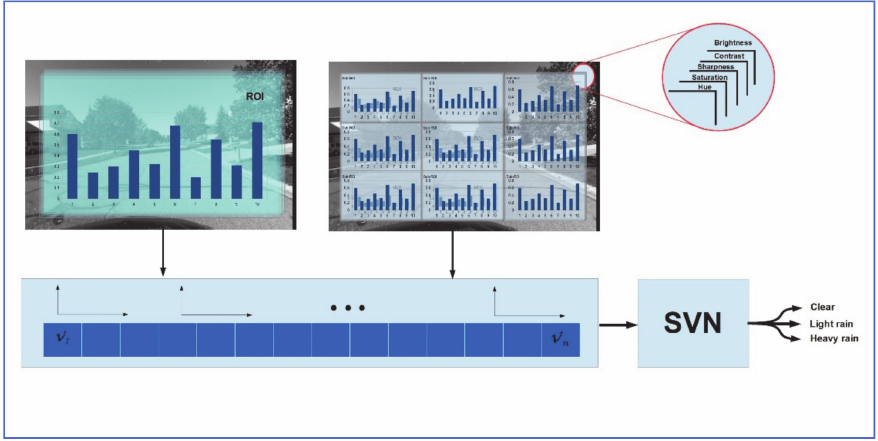
Figure 4. Weather classification using BoF and SVM as described by Roser and Moosmann [16]. The brightness, contrast, sharpness, saturation, and Hue features of an image ROI are used to construct a BoF. And SVN is then used to classify the rainy condition as Clear, Light rain, or Heavy